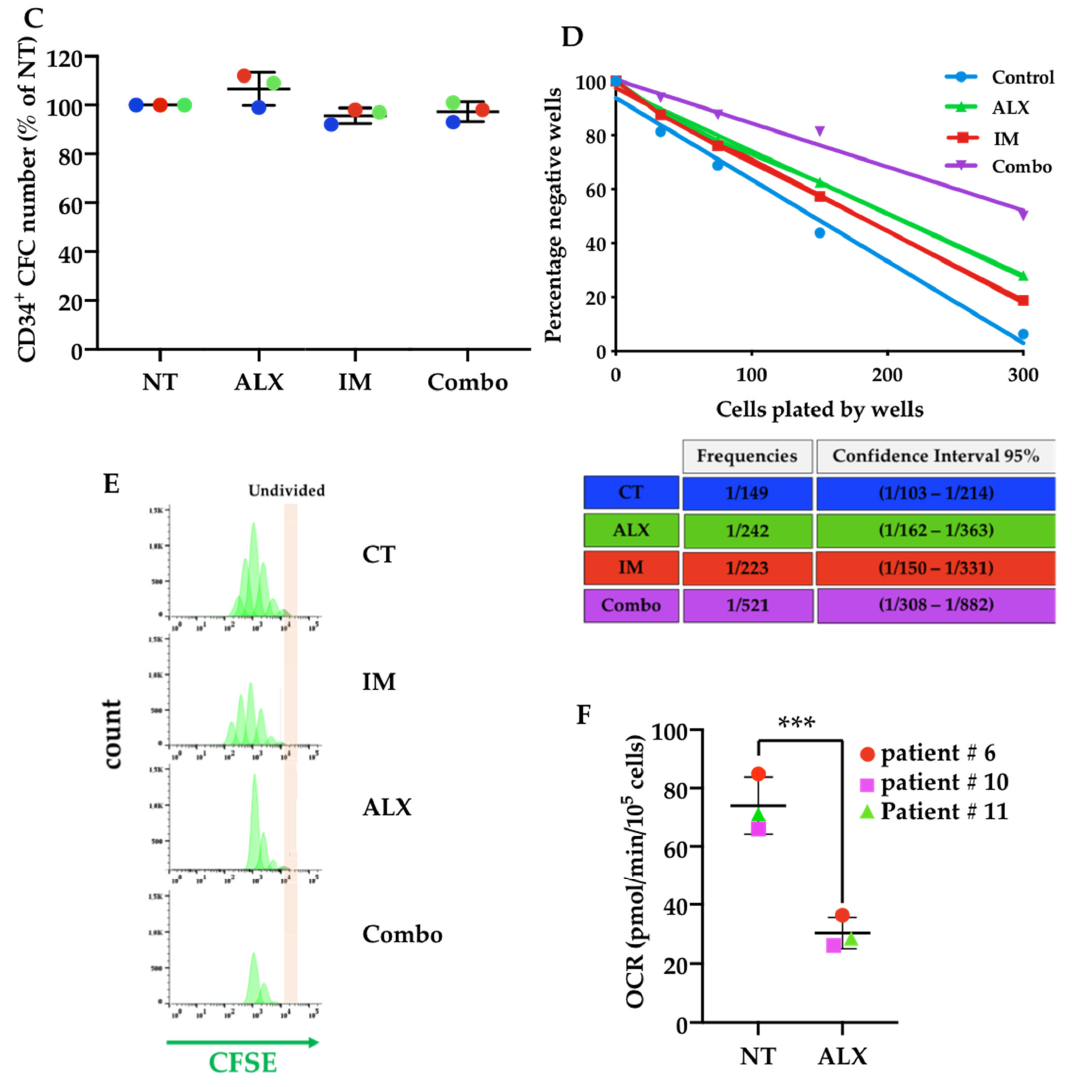
Figure 5. Combination of ALX and Imatinib eliminates CML stem/progenitor cells. ( A ) Evaluation of ALX toxicity. Cord blood CD34+ were transduced with a lentiviral vector expressing BCR::ABL1 (eGFP- BCR::ABL1) or not (eGFP) and incubated 48 h with DMSO (CT), 1 µ M Alexidine (ALX), 1 µ M imatinib (IM) or combination of ALX and IM (Combo). The clonogenic capacity of cells was examined after 14 days. Error bars represent SD for 3 biological replicates. **** p < 0.0001, 2-way ANOVA analysis. ( B ) Clonogenic capacity of primary CD34 + cells from 15 diagnosed CML patients, treated with DMSO (NT), 1 µ M Alexidine (ALX), 1 µ M imatinib (IM) or combination of ALX and IM (Combo) was examined after 14 days. **** p < 0.0001, 2-way ANOVA analysis. ( C ) Clonogenic capacity of primary CD34+